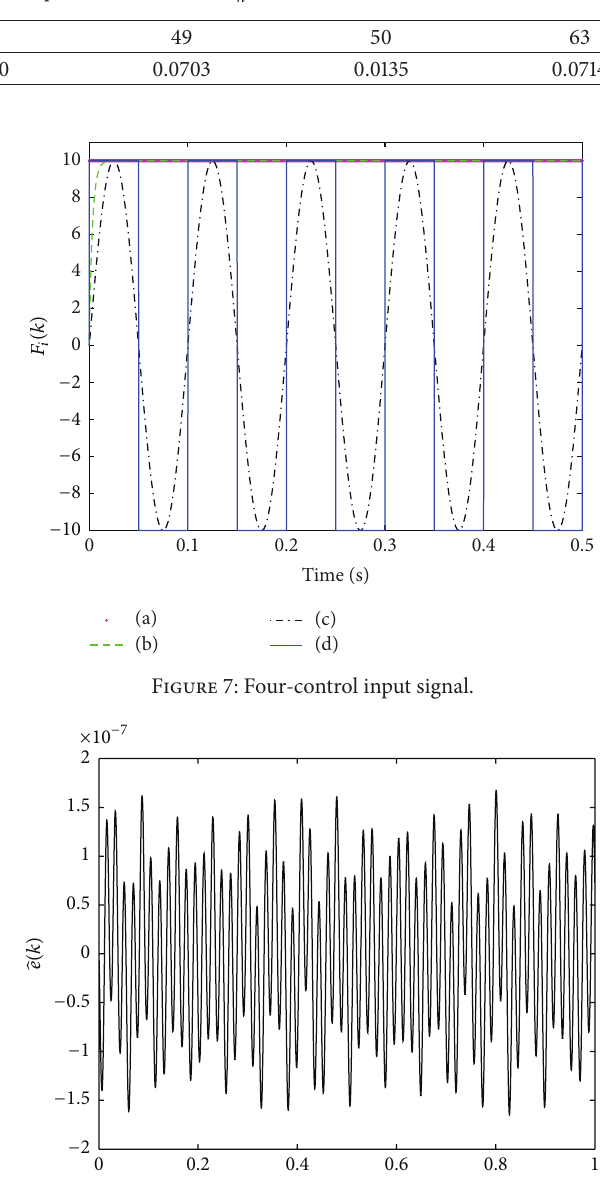
Table 5: 𝑦 -direction maximum amplitude of beams in 𝑁 ℎ .